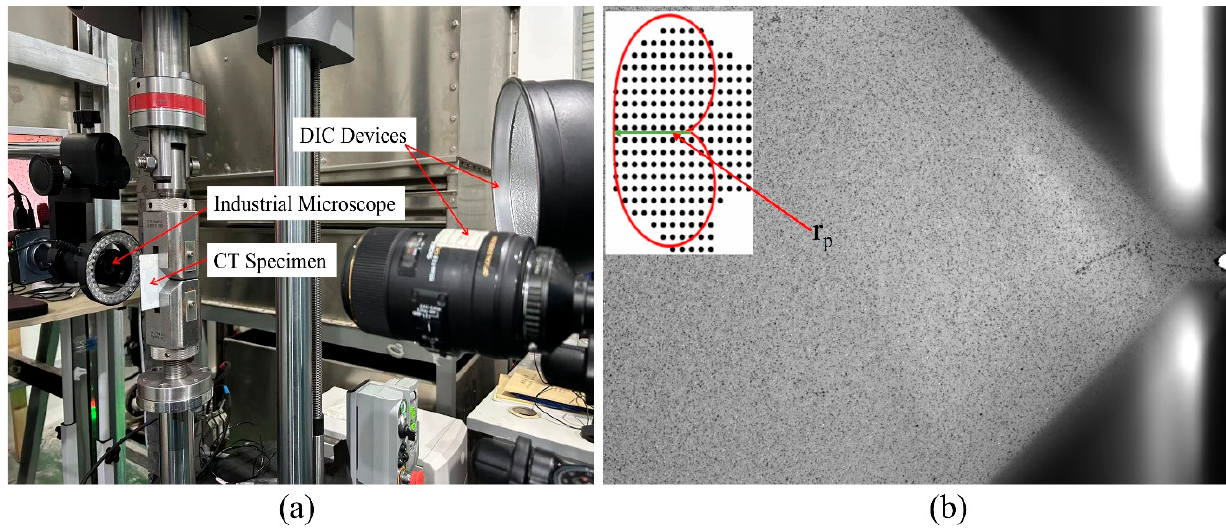
Figure 6. Test loading device, ( a ) DIC acquisition device, ( b ) speckle pattern and the tip radius diagram.